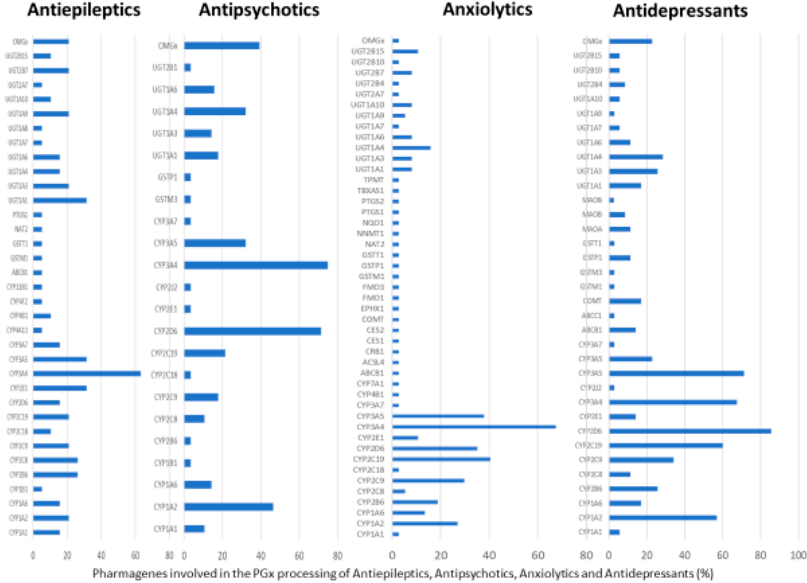
Figure 2. Substrates of antiepileptics, antipsychotics, anxiolytics, and antidepressants.